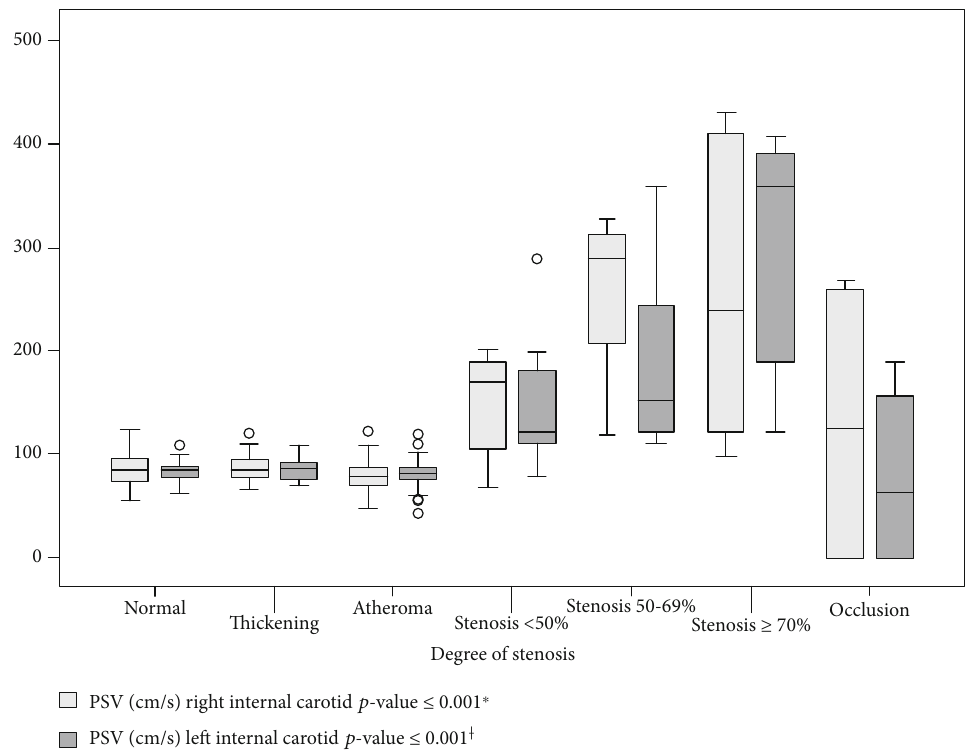
Figure 1: Box plot of the peak systolic velocity (cm/s) ( y -axis) by the degree of stenosis. Signi fi cant di ff erences for PSV (cm/s) between degrees of stenosis by the Kruskal-Wallis nonparametric test for the right internal carotid ( ∗ ) and for left internal carotid ( †